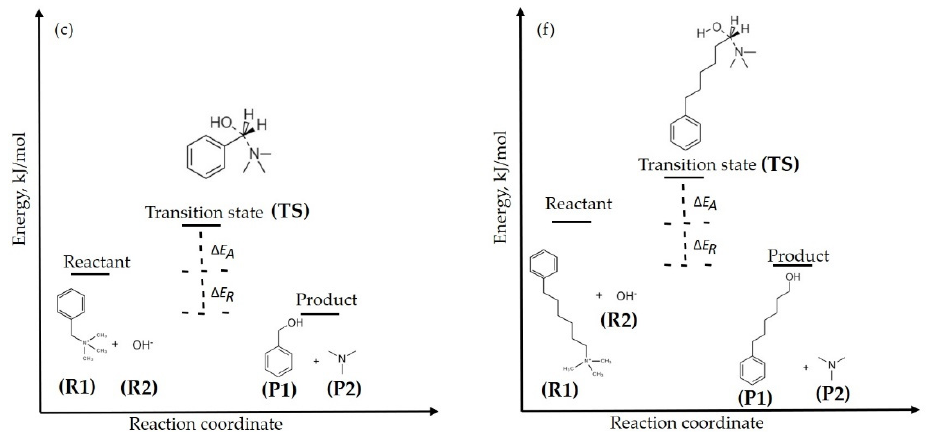
Figure 2. S N 2 degradation reaction mechanism for QA head groups, BTMA ( c ) and TMHA ( f ), at the different HLs.